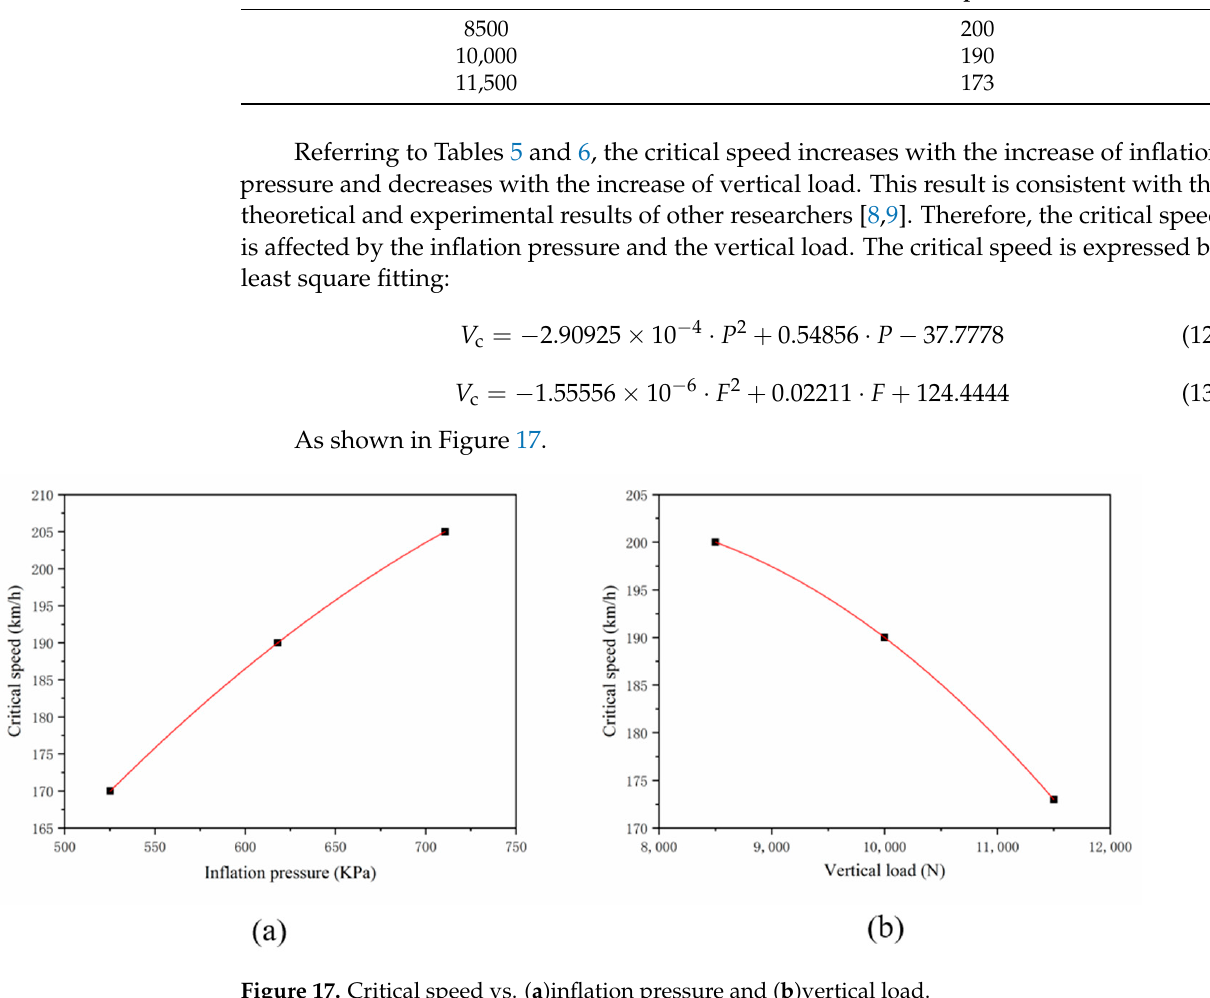
Table 6. Standing wave simulation results based on vertical load change. Vertical Load (N)